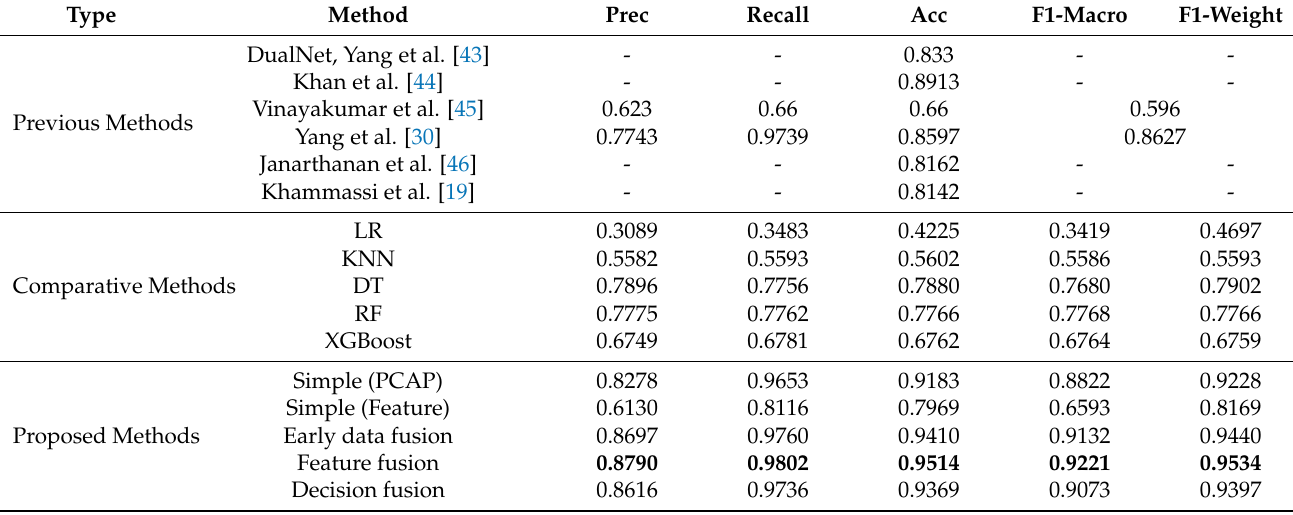
Table 4. Experiment results and comparation of data